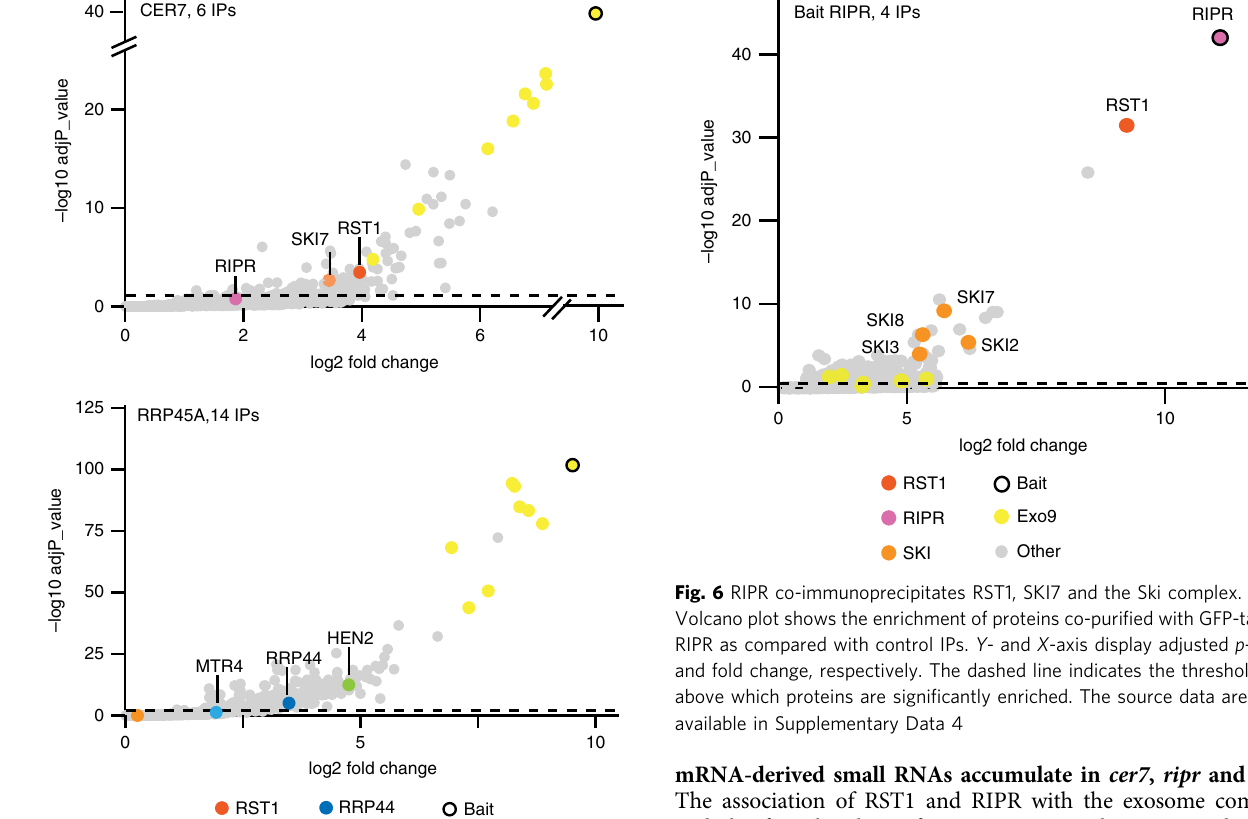
(Fig. 3). Because T-DNA insertion mutants in the AT5G44150 locus were not available in Arabidopsis stock centres, we obtained two independent mutants using a CRISPR-Cas9 strategy. The mutants, named ripr(insT) and ripr(insC) , had single T or C nucleotides inserted at position 179, creating premature stop codons 60 and 65 amino acids after the start codon, respectively (Fig. 7b, c; Supplementary Fig. 3). Interestingly, ripr(insT) and ripr(insC) mutant plants have glossy green stems resembling the stems of rst1 and cer7 plants (Fig. 7d). Moreover, about 70% of the seeds produced by ripr(insT) and ripr(insC) plants were shrunken, similar to the proportion of unviable seeds produced by rst1-2 , rst1-3 or cer7-3 plants (Fig. 7e; Supplementary Fig. 4) 47 . RNA blots con fi rmed that the wax-de fi cient phenotype of ripr (insT) and ripr(insC) is due to the accumulation of CER3 -derived small RNAs and silencing of the CER3 mRNA (Fig. 7f). Those results demonstrate that RIPR can, like RST1, suppress the pro- duction of small RNAs from the CER3 locus. Finally, 56/56 Hc1 ripr(insT) plants triggered silencing of the GUS PTGS reporter (Fig. 7g), demonstrating that RIPR also supresses transgene silencing. Taken together, loss of RIPR induced very similar physiological and molecular phenotypes as loss of RST1 or the exosome subunit CER7.